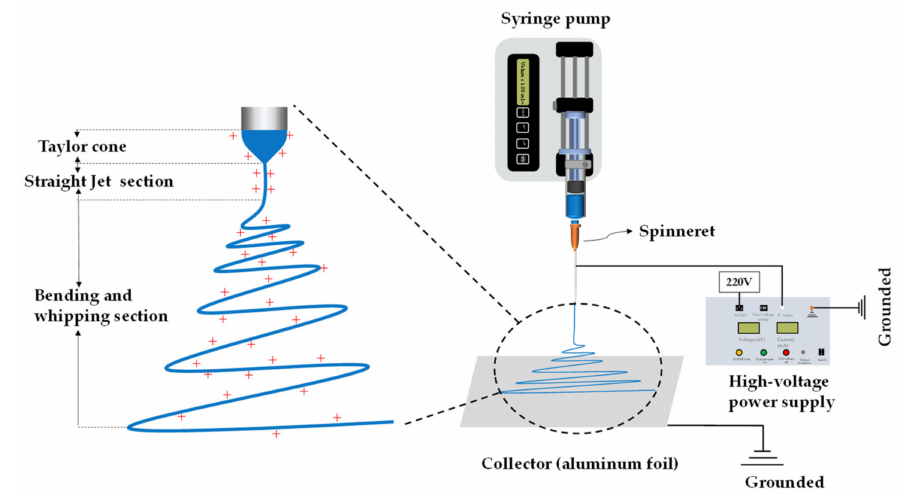
Figure 4. Schematic of the electrospinning process and